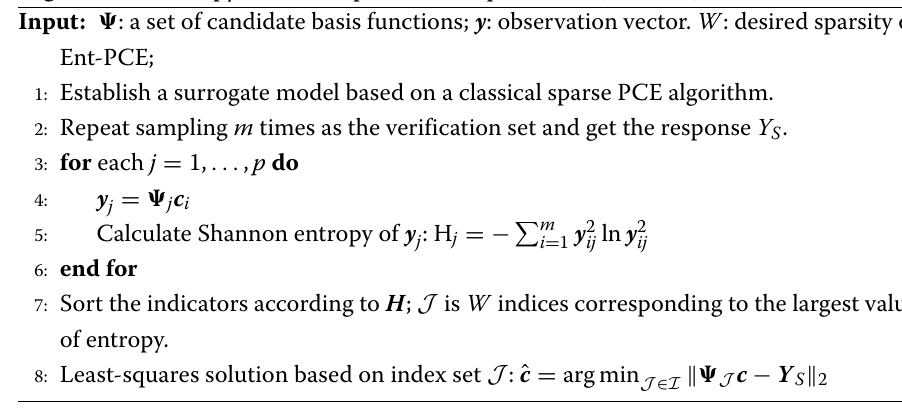
Algorithm 1 Entropy-based re-optimization sparse PCE